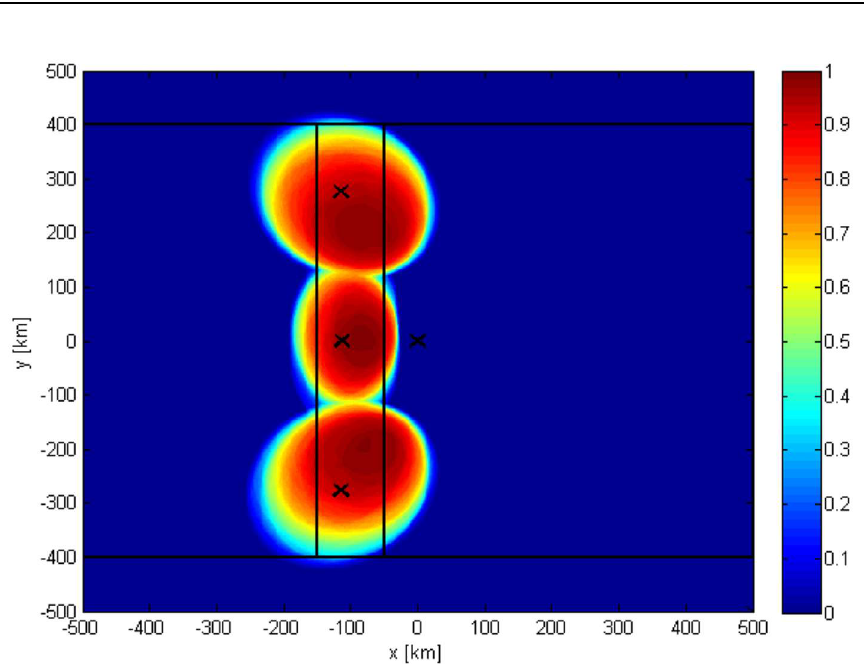
Figure 18. ICARUS uplink satellite antenna gain contour, color code: probability of successful packet reception.